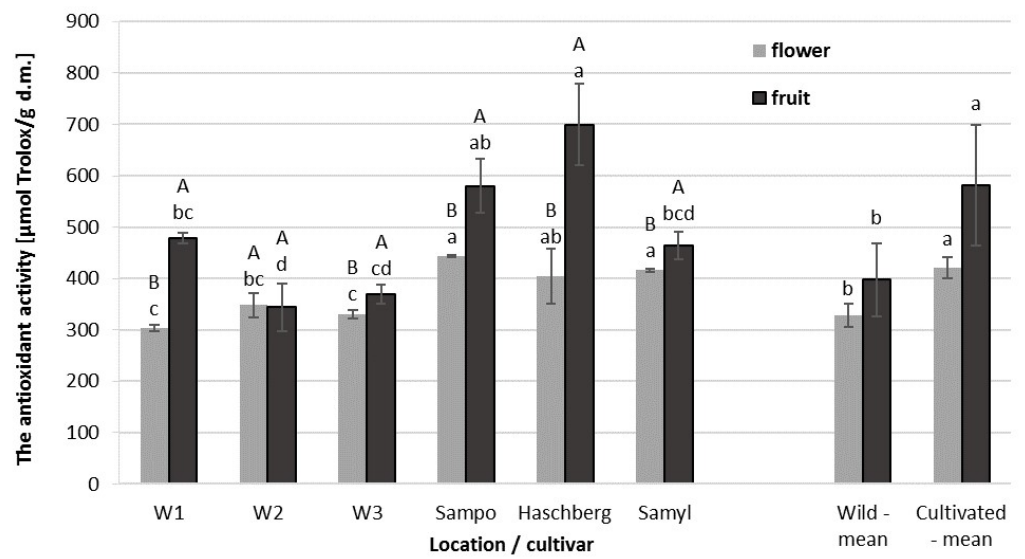
Figure 1. Antioxidant activity in elderberry flowers and fruit, depending on location, wild plants and cultivar. ( A , B ) Di ff erences between flowers and fruit per location (wild plants) and cultivar, statistically cultivar. ( A , B ) Differences between flowers and fruit per location (wild plants) and cultivar, significant at p < 0.05; (a,b,c,d) di ff erences between flowers or fruit from di ff erent locations, wild plants statistically significant at p < 0.05; (a,b,c,d) differences between flowers or fruit from different locations, wild plants and cultivar, statistically significant at p < 0.05. d.m., dry mass. and cultivar, statistically significant at p < 0.05. d.m., dry